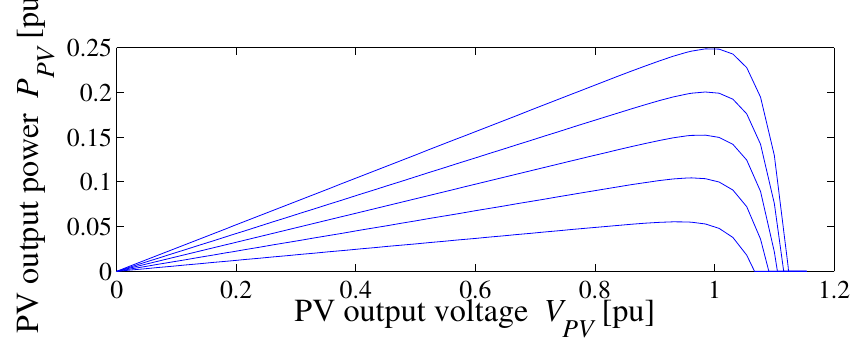
Figure 3. Output characteristics curve (P-V curve) of PV.